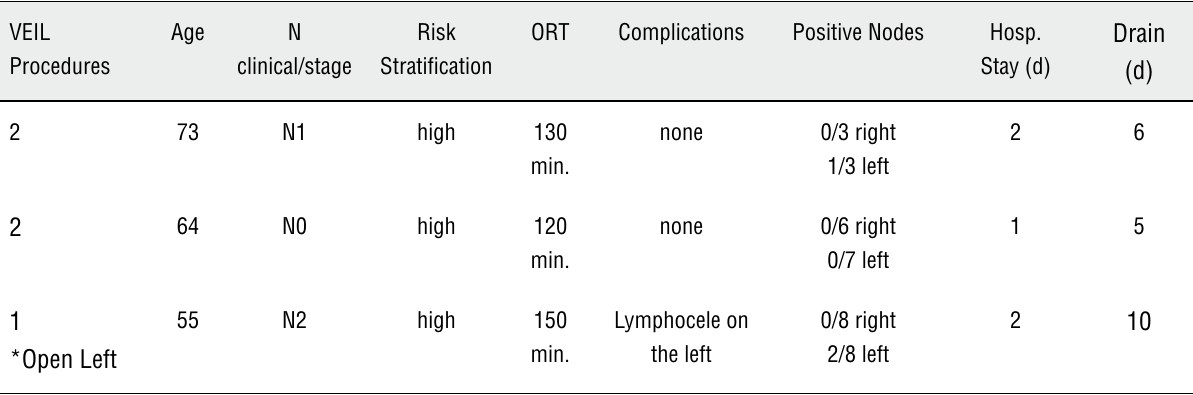
Table1 - Patient’s characteristics and outcomes.